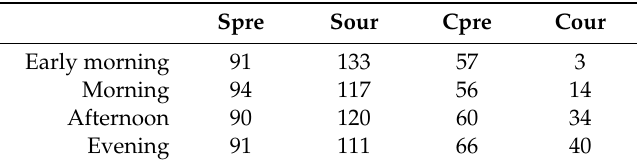
Table 7. Comparison of the number of di ff erent coreness values obtained by a previous method and our method. Spre and Sour, number of di ff erent coreness values obtained by the previous method and our method, respectively. Cpre and Cour, number of places in the core layer obtained by the previous method and our method,